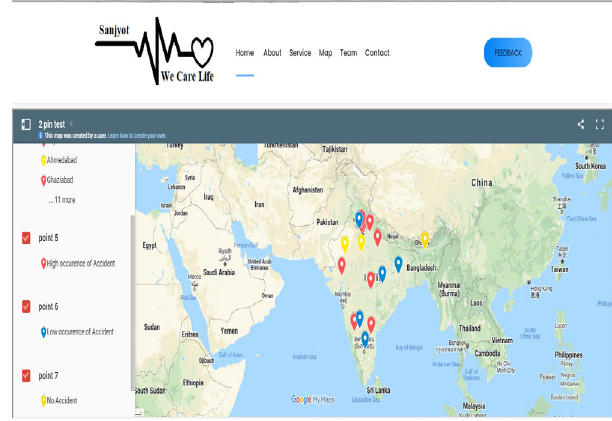
Figure 17. Map shows highly accident prone area, low accident prone area and no accident prone